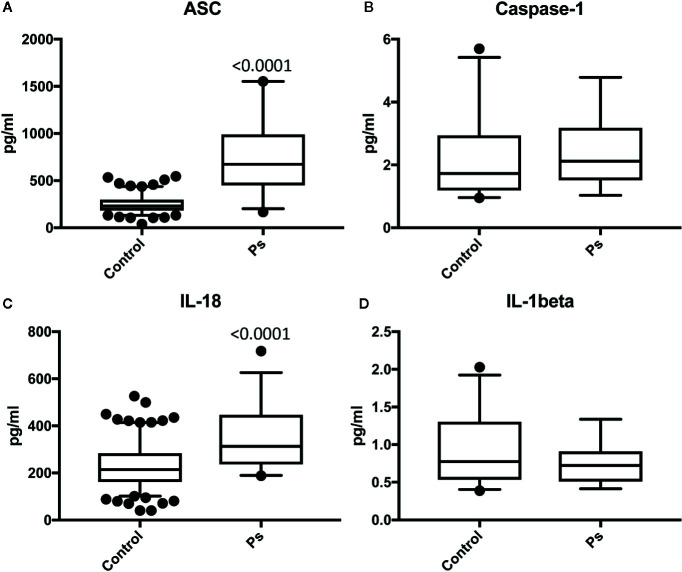
ASC and IL-18 are elevated in the serum of patients with psoriasis. Protein levels in pg/ml of ASC (A), caspase-1 (B), IL-18 (C), and IL-1b (D) in serum samples from patients with psoriasis/PA and healthy donors (controls). ASC: N = 156 controls, 36 psoriasis/PA; caspase-1: N = 25 controls, 19 psoriasis/PA; IL-18: N = 180 controls, 36 psoriasis/PA IL-1beta: N = 32 controls, 14 psoriasis/PA. Box and whiskers are shown for the 5th and 95th percentile.